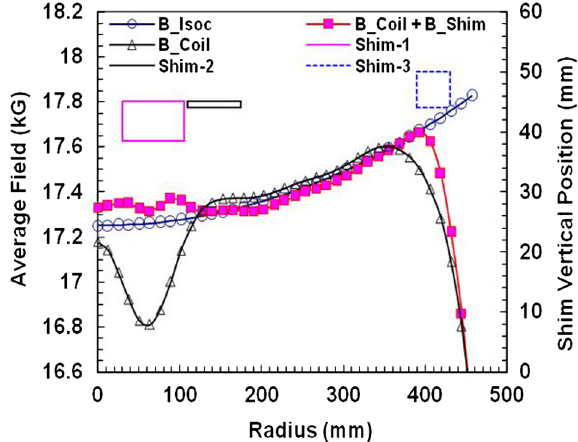
FIG. 9. Average magnetic field after adding thin iron shims near the center of the cyclotron and at the extraction